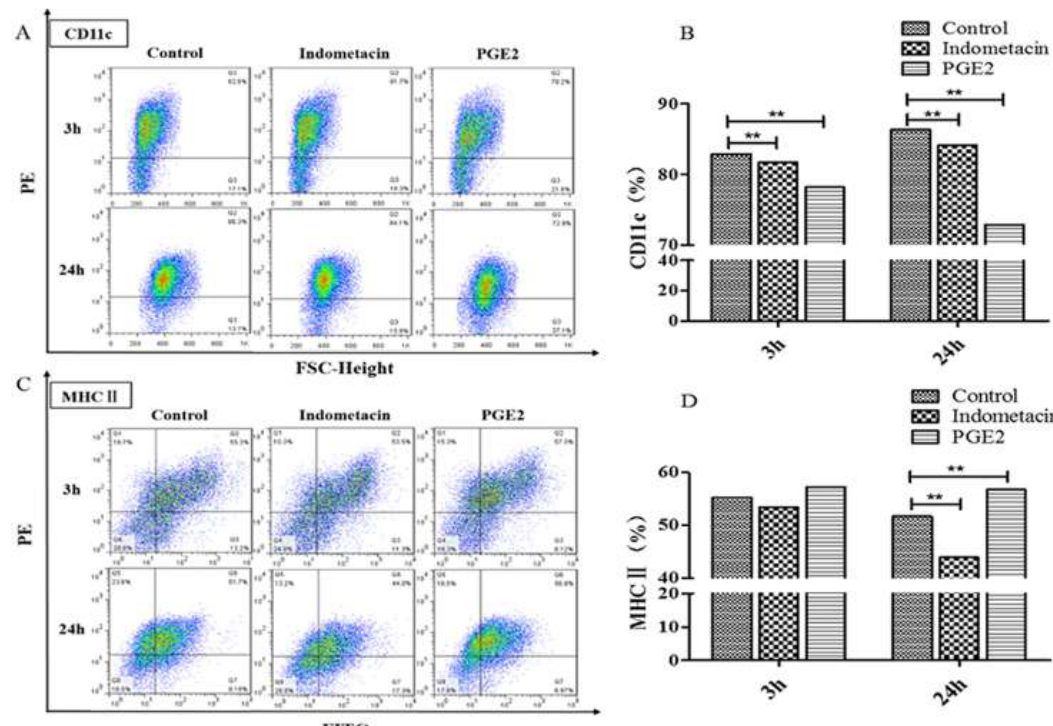
Figure 5. The differentiation of DCs associated with PGE2. DCs were co-incubated with 50mg/mL Figure 5. The di ff erentiation of DCs associated with PGE2. DCs were co-incubated with 50mg / mL indomethacin and 20ng/mL exogenous PGE2 independently. Expression of DCs surface Ag PE- indomethacin and 20ng / mL exogenous PGE2 independently. Expression of DCs surface Ag PE- CD11c CD11c ( A and B ) and FITC-MHC II ( C and D ) were measured with flow cytometry. ( A and B ) and FITC-MHC II ( C and D ) were measured with flow